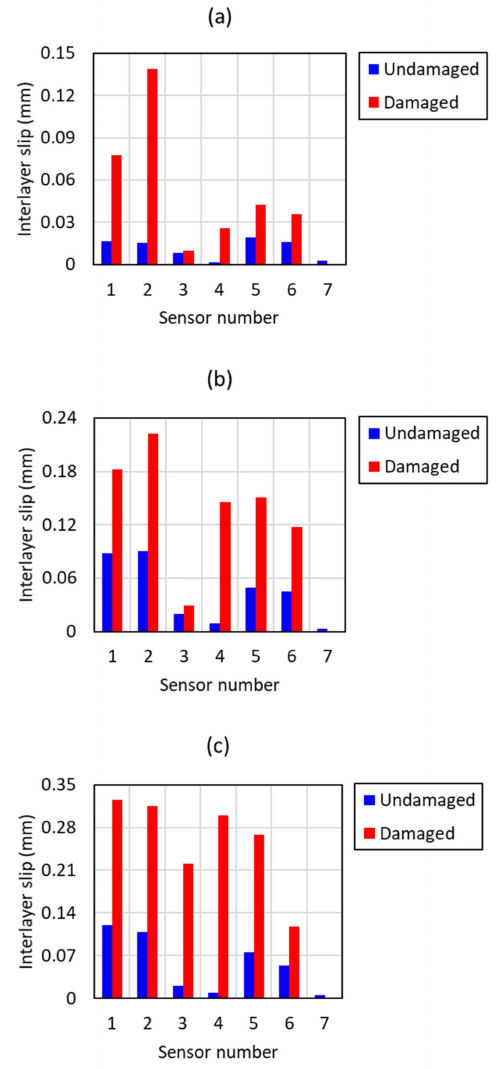
Figure 15. Structural damage detection for double damage in terms of ( a ) first load increment, ( b ) second load increment and ( c ) third load